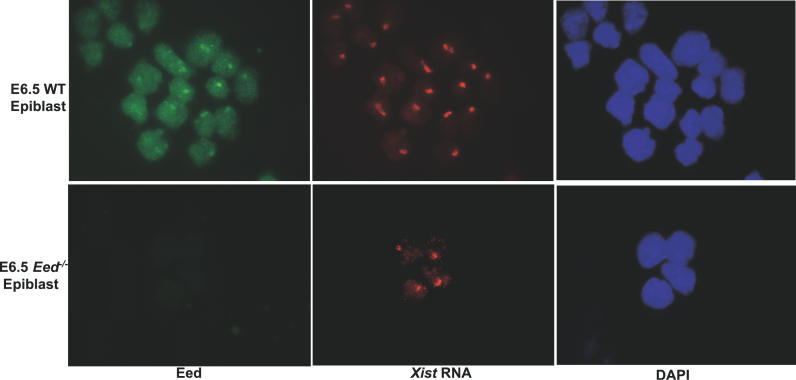
Absence of EED Protein in Epiblast Cells of E6.5 Eed
−/− EmbryosIF-FISH detection shows that whereas isolated E6.5 WT epiblast cells accumulate EED on the Xi, denoted by Xist RNA coating, epiblast cells from Eed
−/− female embryos lack such enrichment.